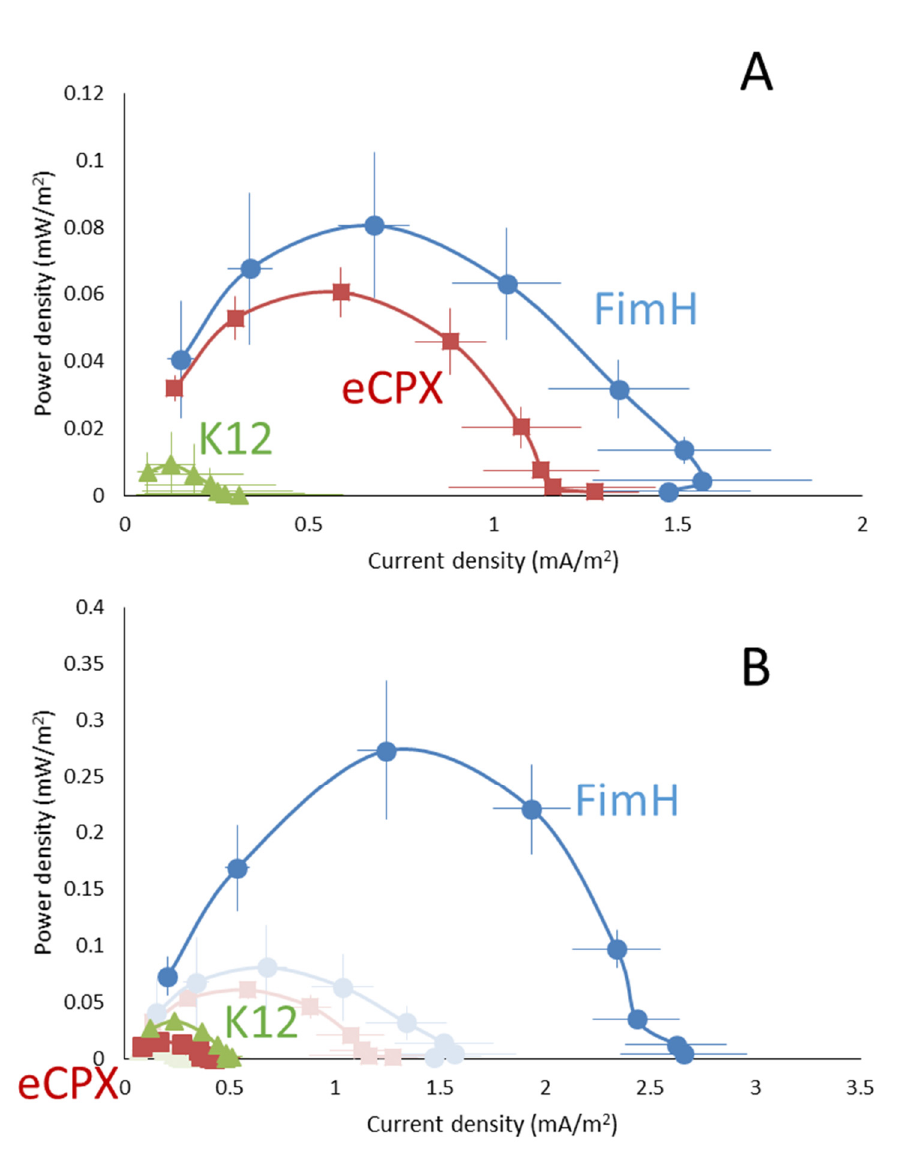
Figure 5. Variable resistance data at 1 day ( A ) and 5 days ( B ) for the same runs as shown in Figure 4. The 1 day data is shown grayed (faded?) out in B for comparison. At 1 day, cells displaying p8#9 in the FimH and eCPX have similar power and current densities, which are 3–5 times higher than the power densities achieved with the K12 control. At 5 days the power density with the FimH scaffold and with the K12 control have increased by a factor of 3, while the power density with the eCPX scaffold has declined. The error bars show 1 standard deviation away from the mean.